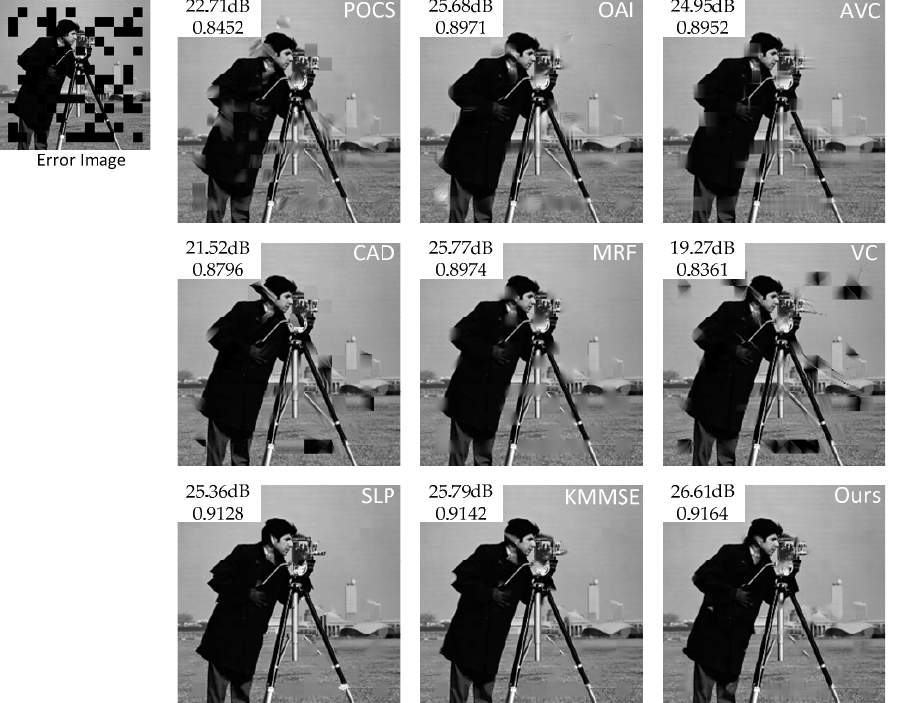
Figure 21. Subjective comparison of different EC algorithms on the Cameraman image with 16 × 16 random block loss. The corresponding PSNR and SSIM values are also shown in the upper left corner.